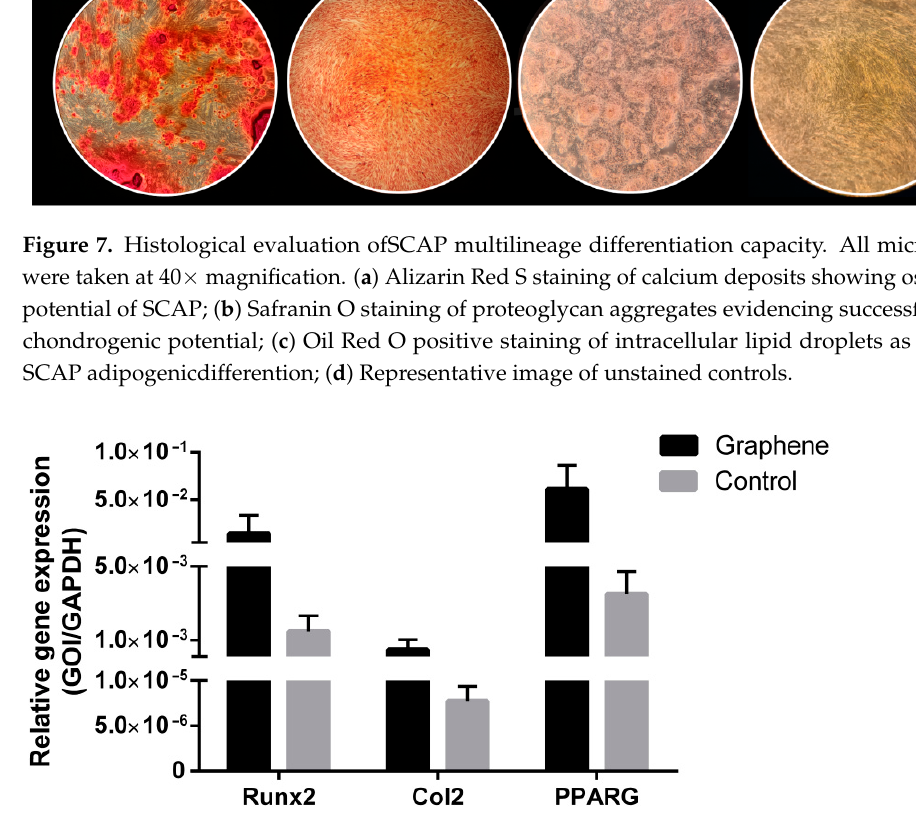
Figure 7. Histological evaluation ofSCAP multilineage differentiation capacity. All micrographs were taken at 40× magnification. ( a ) Alizarin Red S staining of calcium deposits showing osteogenic potential of SCAP; ( b ) Safranin O staining of proteoglycan aggregates evidencing successful SCAP chondrogenic potential; ( c ) Oil Red O positive staining of intracellular lipid droplets as a sign of SCAP adipogenicdifferention; ( d ) Representative image of unstained controls.